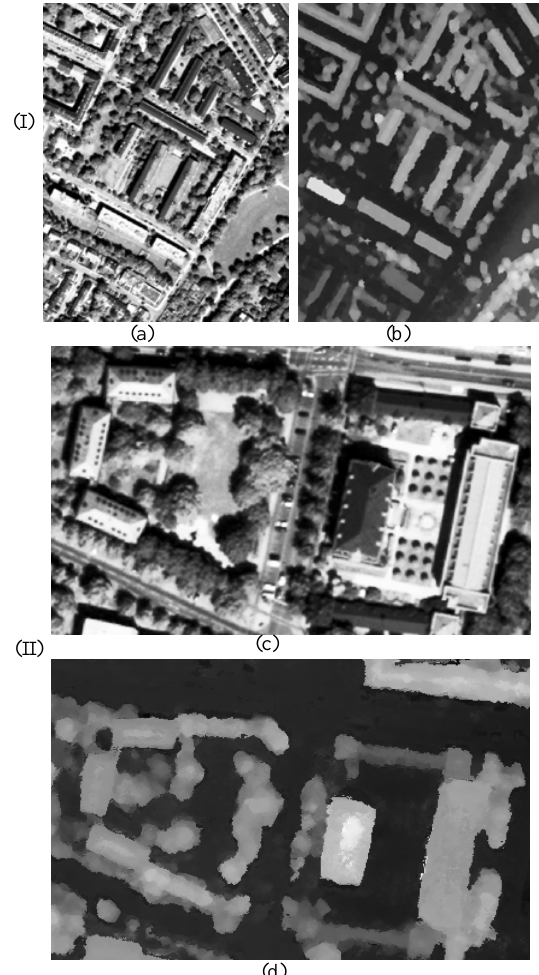
Figure 4. Test dataset of areas I and II. (a) and (c) orthorectified pansharpened images. (b) and (d) DSM.